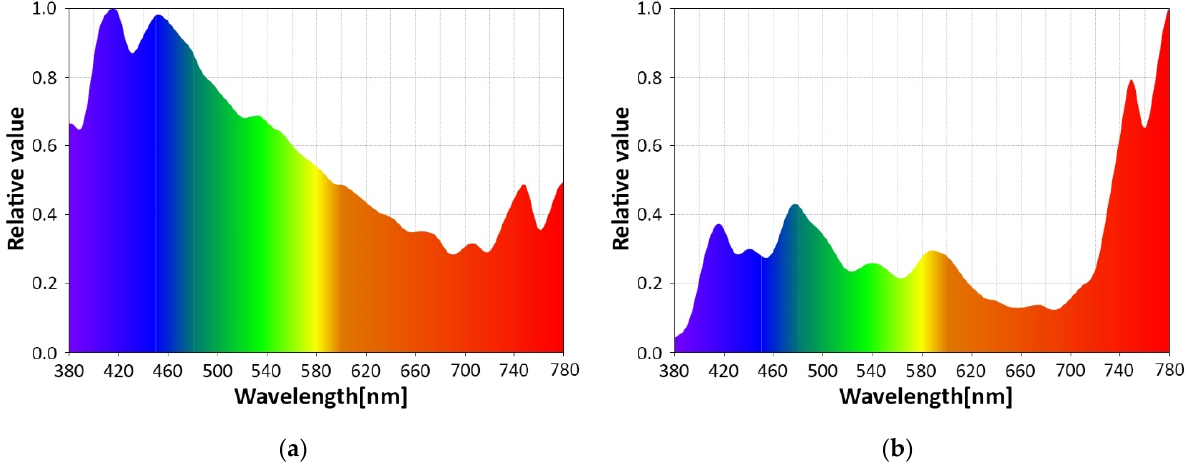
Figure 9. Spectral analyses of the VLC channel: ( a ) outdoor afternoon conditions; ( b ). in-vehicle conditions.